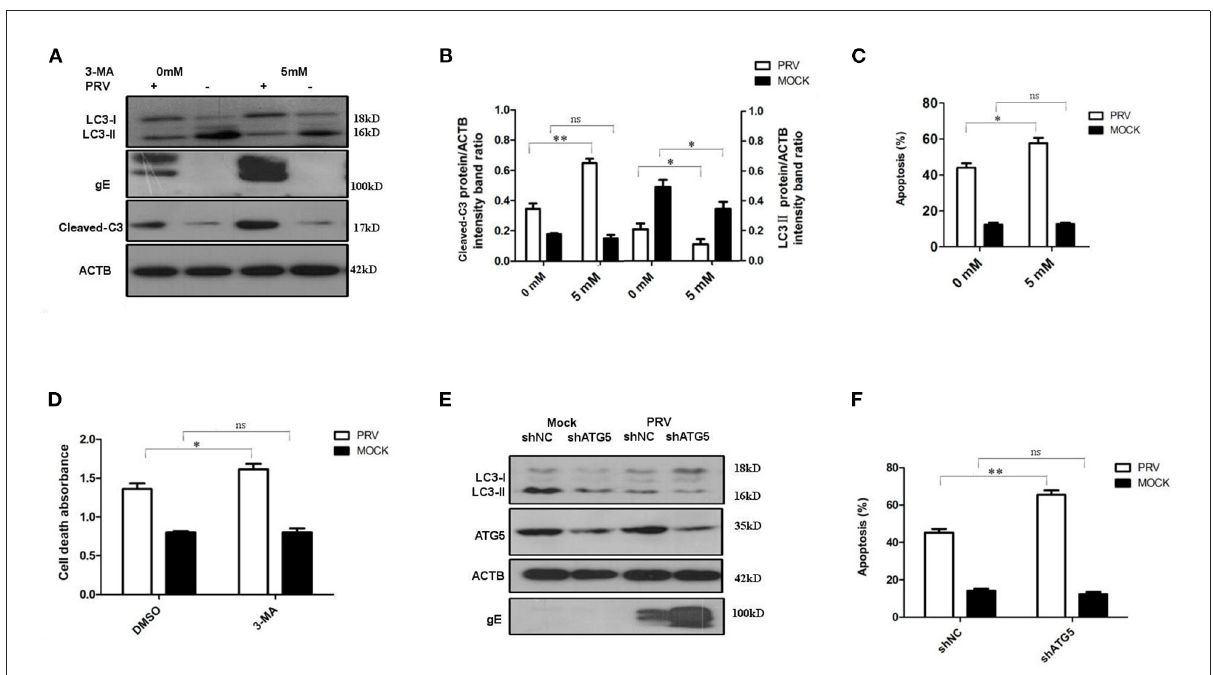
FIGURE2 The inhibition of autophagy increases PRV-induced apoptosis. (A) PK-15 cells were treated with 3-MA, followed by PRV infection. The cells were lysed and analyzed by Western blot. And the statistical analysis of cleaved-caspase-3/ACTB was performed and shown in (B) . (C) PK-15 cells were treated as in (A) and analyzed by flow cytometry. The percentage of apoptotic cells was represented as the histogram. (D) The cells were treated as in (A) and lysed, followed by cell-death ELISA analysis. (E) PK-15 cells were transfected with shRNAs for 24h, followed by PRV infection. The expression of the ATG5 protein and autophagic level was detected by Western blot. (F) The cells were treated as in (E) and analyzed by flow cytometry. The percentage of apoptotic cells was shown in the histogram. All the dates are representative of three independent experiments. The data represent the mean ± SD, and analyzed by two-way ANOVA, * P < 0.05; ** P < 0.01.